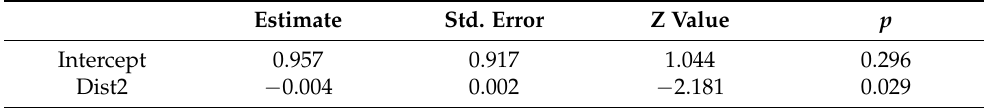
Table 2. The best generalized linear model (GLM), showing the relationship between Harris Hawk occurrence and the minimum distance to large green areas (Dist2) in Buenos Aires city,